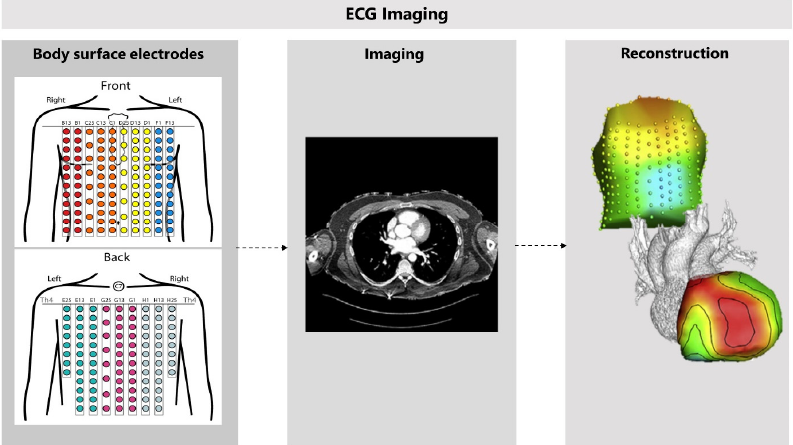
Figure 8. The use of cardiac computed tomography in electrocardiographic imaging. Electrocar- diographic imaging (ECGI) starts with recording body-surface ECGs, using 256 electrodes. Cardiac computed tomography is used to create a patient-specific heart-torso geometry. Epicardial poten- tials can be mathematically reconstructed when combining these results. Adapted with permission from Cluitmans et al. [84] and permission from Elsevier, 2018.